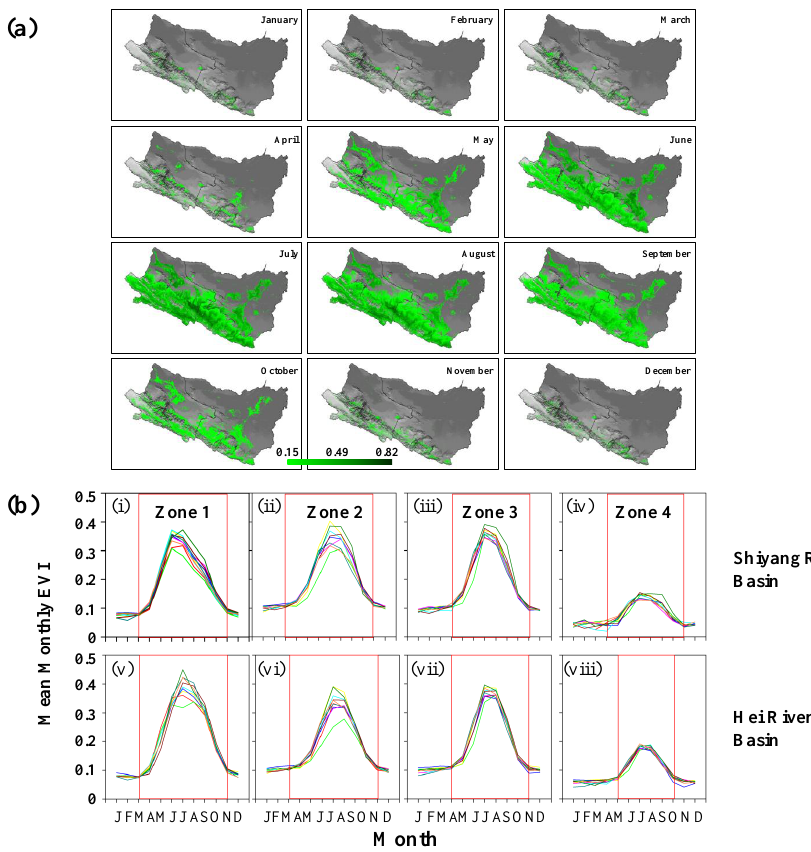
Figure 3. Ten-year average distribution of monthly enhanced vegetation index (EVI ≥ 0.15; non-dimensional) according to time of year (a) and spatially averaged time series of monthly EVI over the course of individual years for 2000–2009 ( b ; shown in different colours). Letters along the x axis of plots in (b) coincide with month, January (J) through to December (D). Vertical red lines denote the approximate month of the onset (first line) and cessation of the growing season (second line) in the Shiyang and Hei river basins,